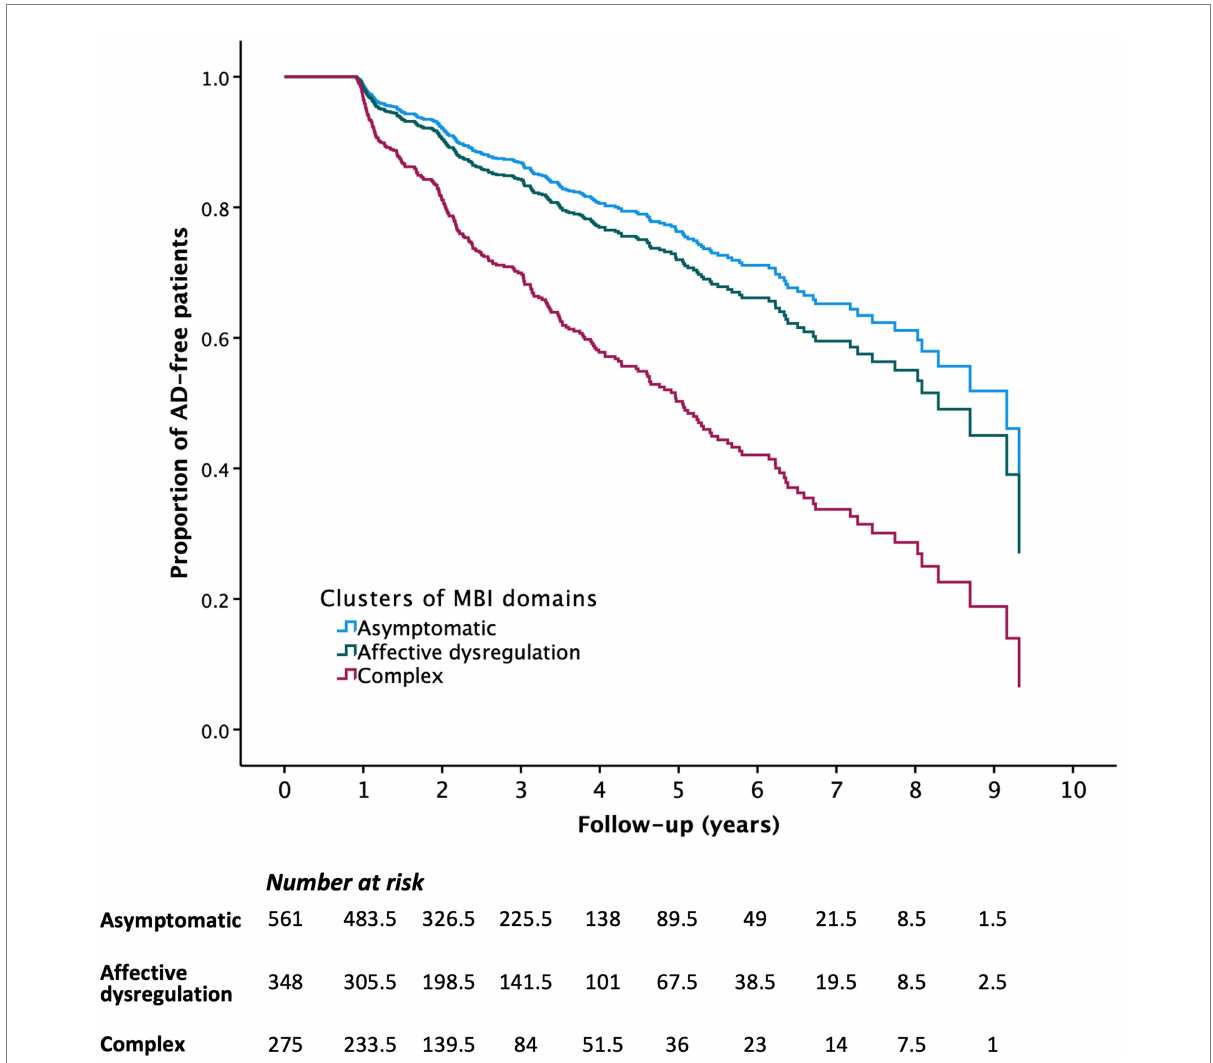
FIGURE 1 Survival curves of progression to Alzheimer’s disease by subgroups of study participants classified based on profiles of MBI domain